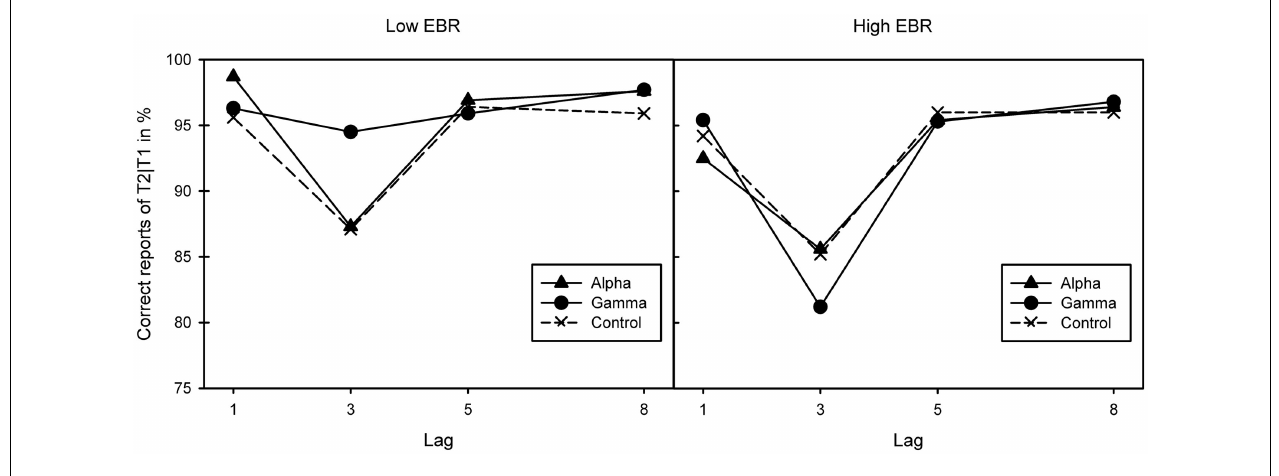
FIGURE 1 | Correct report of T2|T1 for the three binaural beat conditions (alpha, gamma, and control) in the two EBR groups . Lag effects in both the low [left-hand graph; F (1.28, 14.03) = 9.35, p = 0.006, η 2 p = 0 : 46 ] and high-EBR groups [right-hand graph; F (1.35,